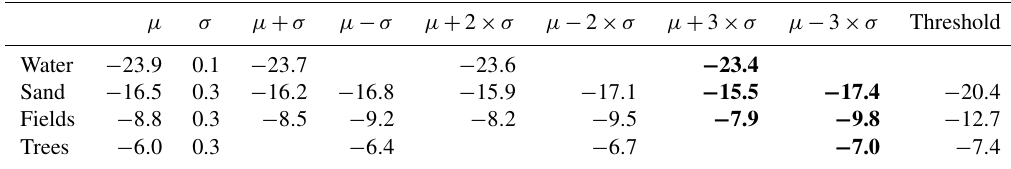
Table B3. Determination of thresholds for a sampling duration of 2 weeks and a 25 × 25 boxcar filter. Values in bold are those that have been used to calculate the threshold indicated in the last column. All values are in decibels (dB). µ – mean. σ – standard deviation.